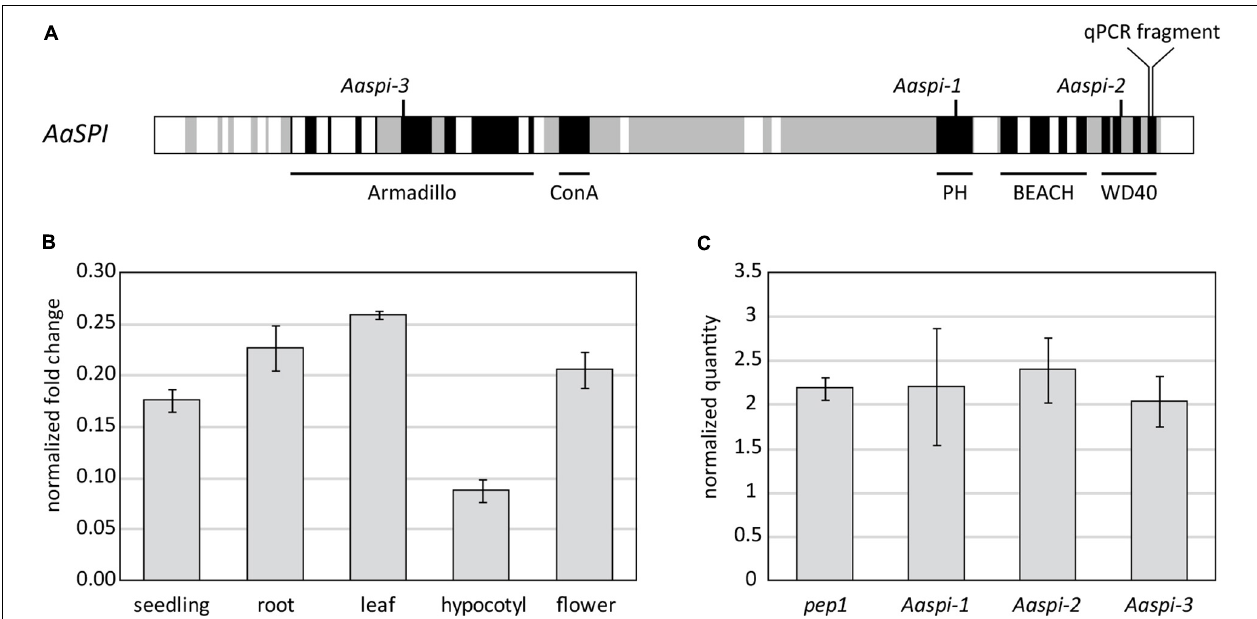
FIGURE 1 | Molecular characterization of the SPIRRIG gene in Arabis alpina . (A) Schematic presentation of AaSPIRRIG . Exons are shown in gray, functional domains are depicted in black. The positions of early stop codons within the spirrig alleles are indicated above. (B) The expression levels of AaSPI were determined in five tissues by qPCR. Normalization was carried out using AaRAN3 (Wang et al., 2009). (C) The expression levels of AaSPI were determined in the above ground parts of seedlings of pep1 , Aaspi-1 , Aaspi-2, and Aaspi-3 by qPCR. Normalization was carried out using AaTUA5 and AaCAC (Stephan et al.,